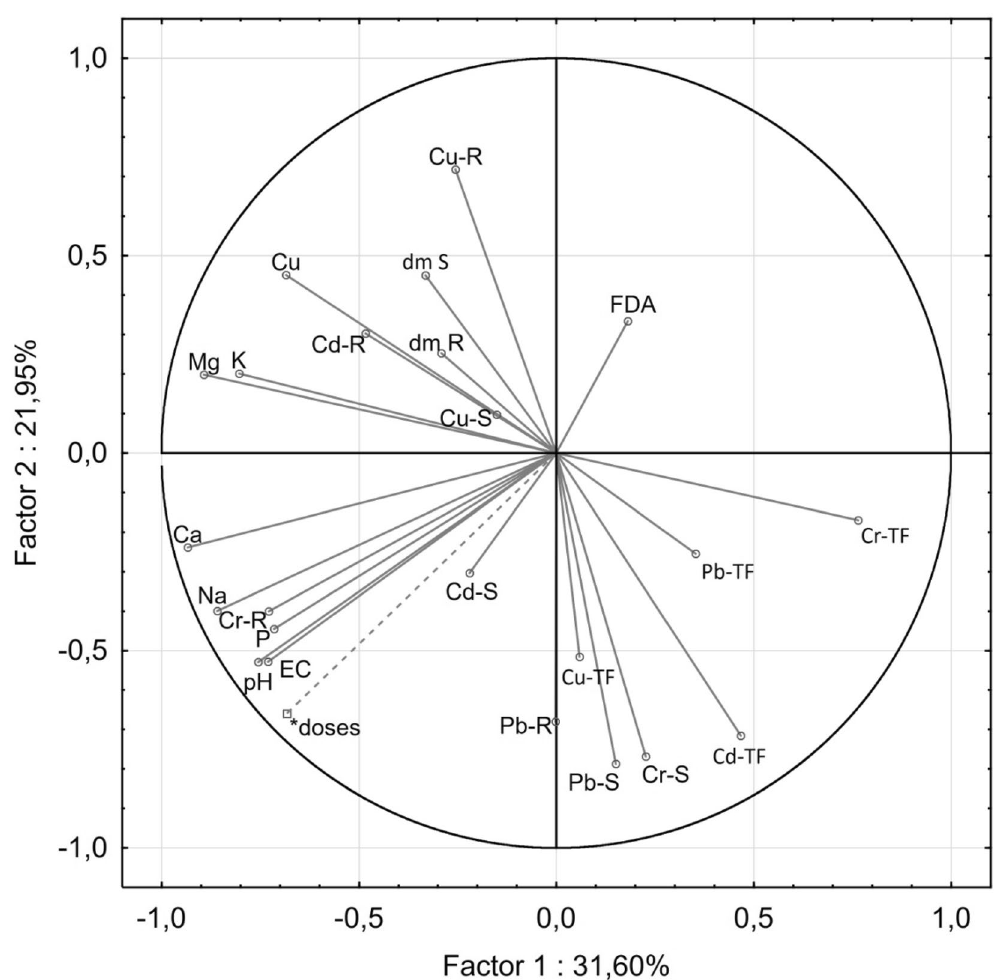
Fig. 4 Principal Component Analysis (PCA) in the amendment of industrial landfill sludge (ILS) doses (0, 2, 5, 10, and 20 Mg ha −1 ) on Typic Paleudult and Grossarenic Hapludult soils. dm dry mass, S shoot, R roots, TF translocation